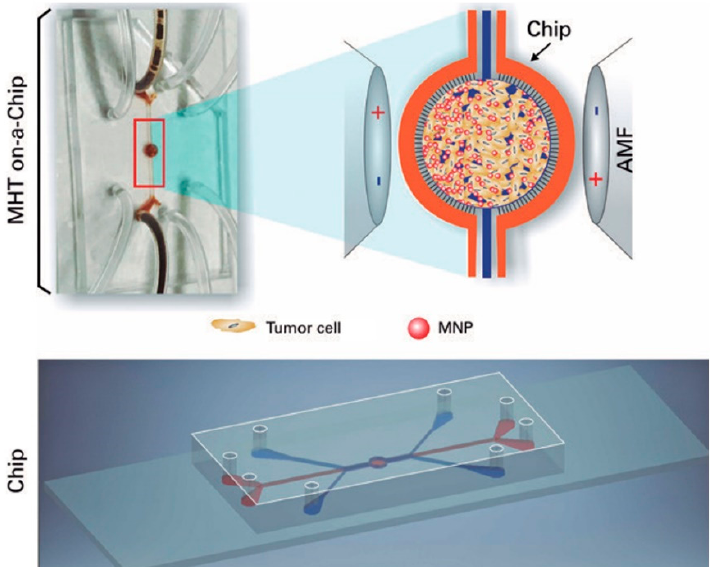
Figure 1. On-a-chip magnetic hyperthermia therapy for GBM. Magnetic nanoparticles interacted with GBM cells in the central region of the chip design, while being exposed to the magnetic field that caused an increase in the heat directly affecting the tumor cells by magnetic nanoparticles [34]. Reproduced with permission from [34].